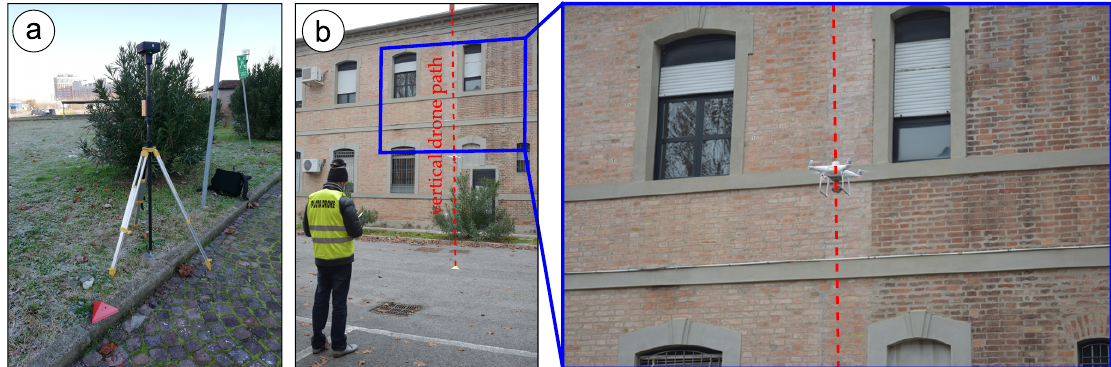
Figure 3. ( a ) DJI D-RTK 2 Mobile Station setup on S1 benchmark; ( b ) Image acquisition with DJI Phantom 4 RTK during aerial survey of F. 2 in manual